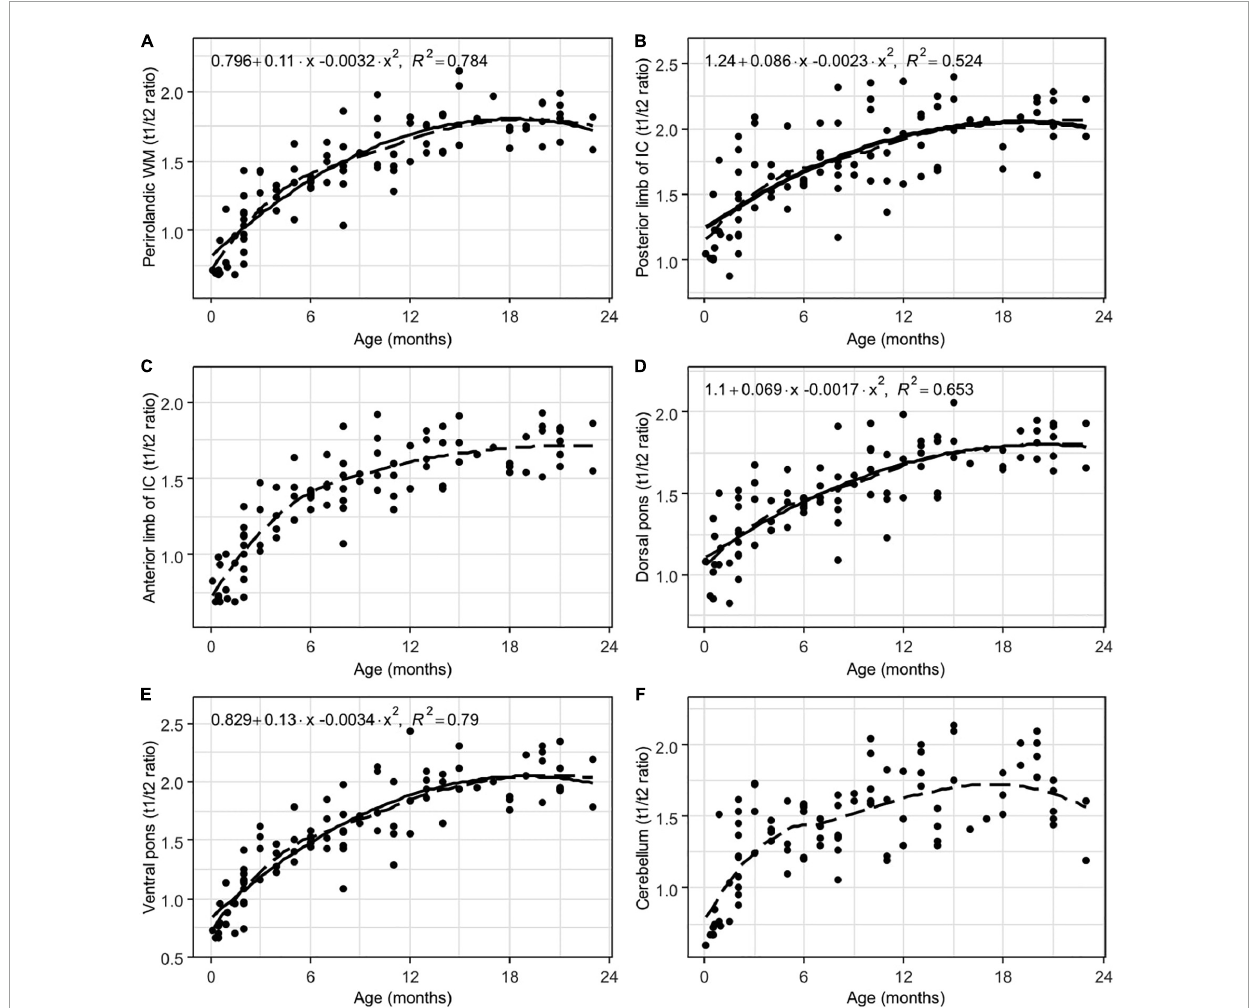
FIGURE5 Results of LOESS and 2nd order polynomial regression analyses between subjects’ age (in months) as the predictor variable and the T1w/T2w ratio values as the response variable in perirolandic white matter (A) , the posterior (B) and the anterior (C) limbs of the internal capsule, the dorsal (D) and the ventral (E) parts of the pons, and cerebellum white matter (F) . The dotted line represents the LOESS regression curve, and the solid line represents the 2nd-order polynomial regression curve (adjusted p <